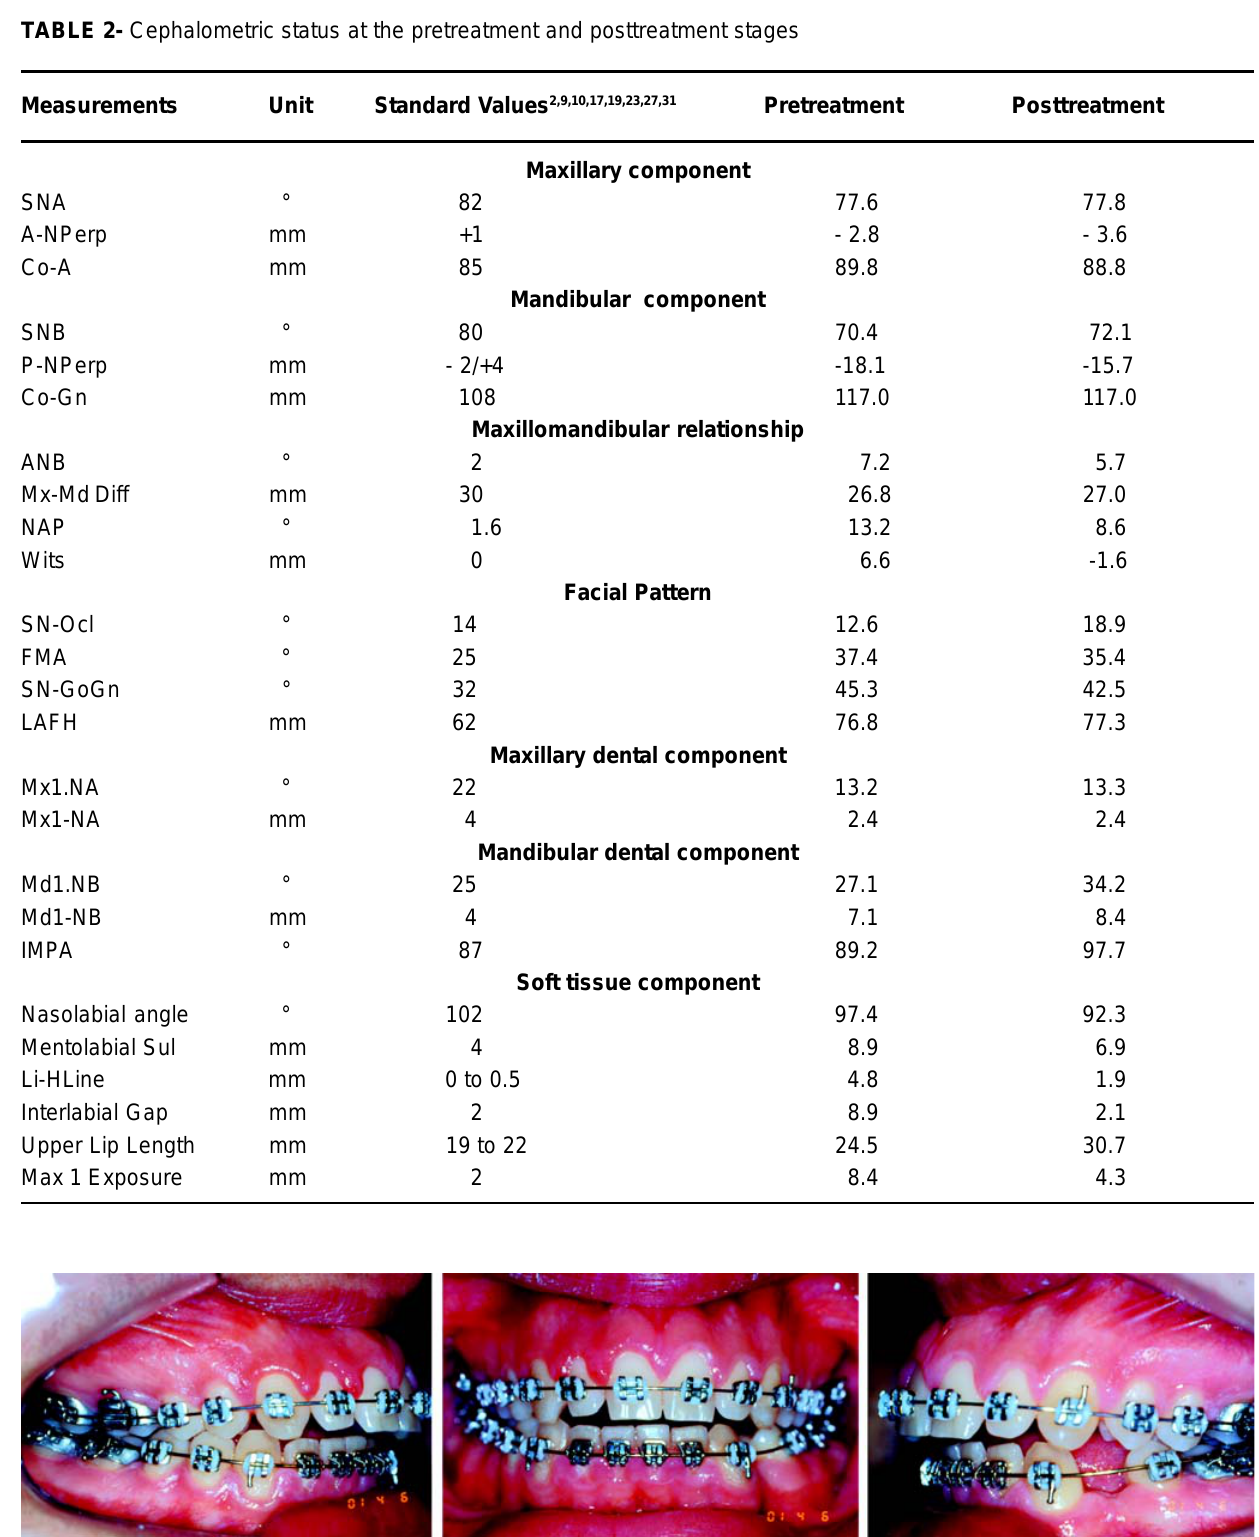
FIGURE 4- Leveling and alignment with 0.020-inch stainless steel